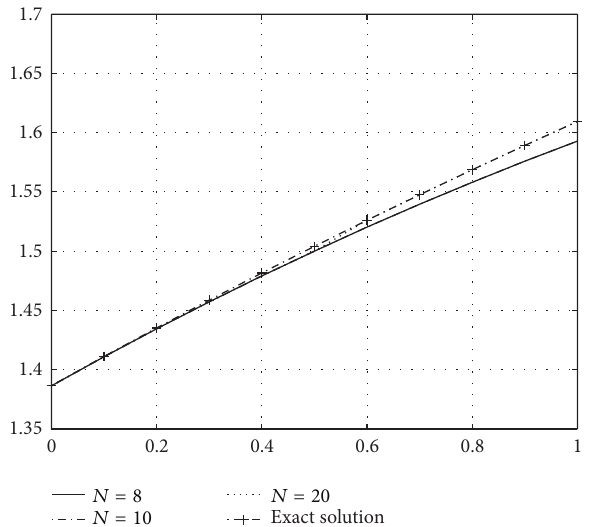
Figure 7: Error function of Example 6 for various 𝑁 values, 𝑁 8, 10, 20